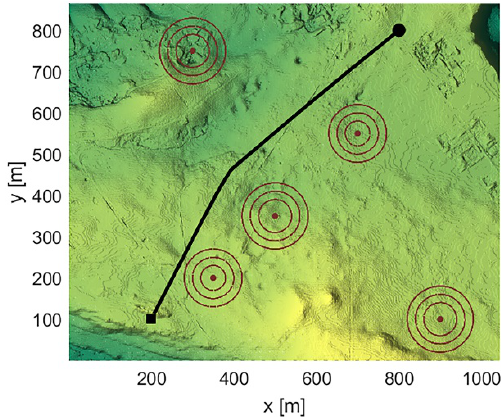
Figure 15. The top view of the paths generated by the IC-VAINDIWPSO algorithm under three threats.